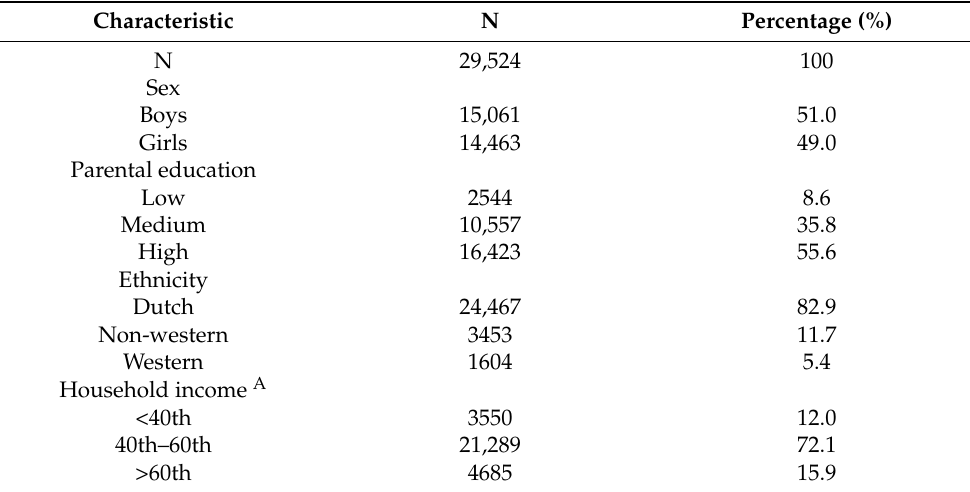
Table 1. Characteristics of included